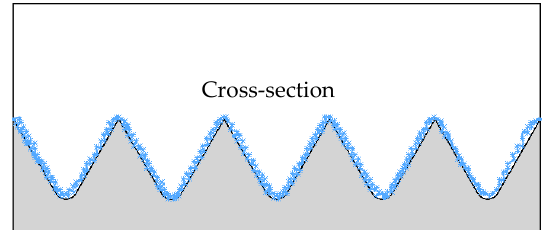
( c ) Diagram of the composite surface of micro-riblets with superhydrophobicity. Figure 1. Schematic diagram of microstructured